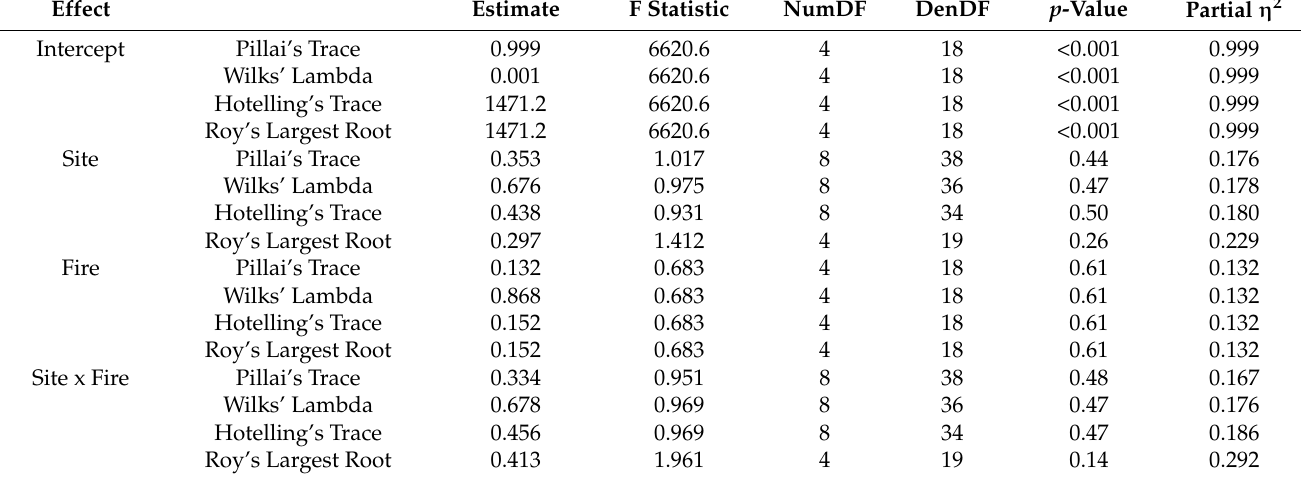
Table A3. Multivariate tests of SOS (start of growing season), EOS (end of growing season), LOS (length of growing